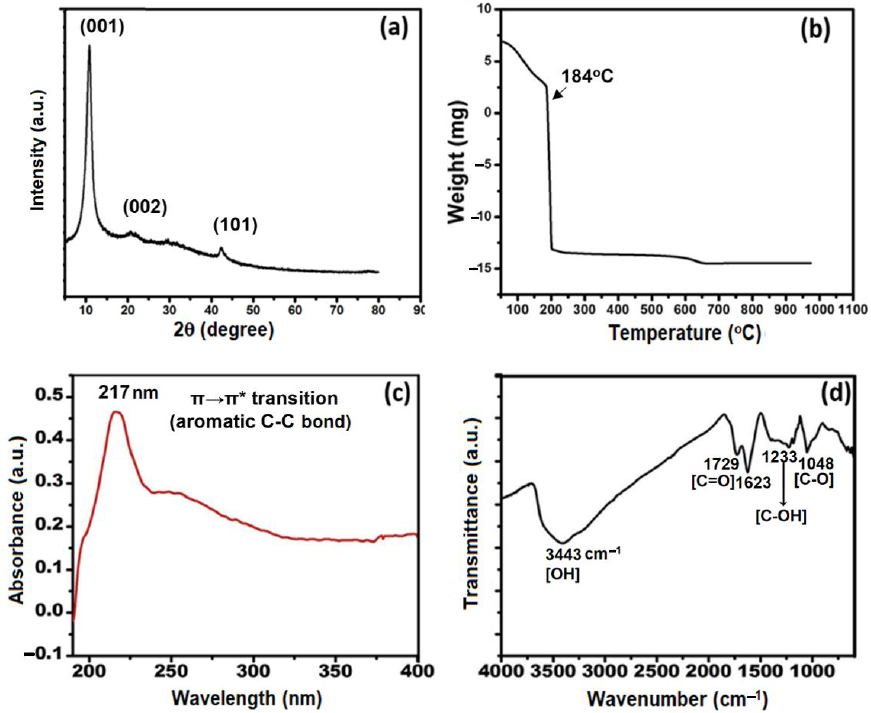
Figure 3. ( a ) XRD profile of dried GO powder, ( b ) TGA thermogram of dried GO from room tem- perature to 1000 °C, ( c ) UV-visible spectrum of GO (concentration = 1 mg.mL − 1 ), and ( d ) FT-IR spec- trum of GO.